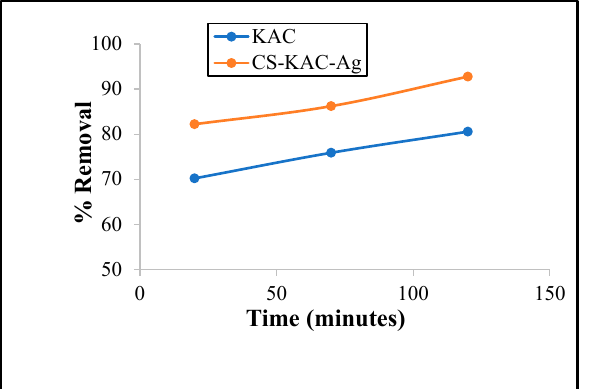
Figure 11. Comparison of % removal of Cd 2+ using KAC and CS ‐ KAC ‐ Ag (10 mg L − 1 L of Cd 2+ , 20 g of adsorbent, pH~6, room temperature).